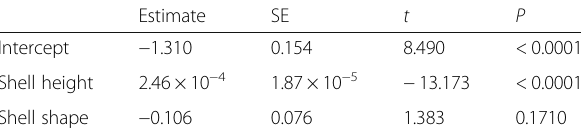
Table 3 Parameter estimates of the optimal linear model for the foot area in the flow tank experiment. SE = standard error